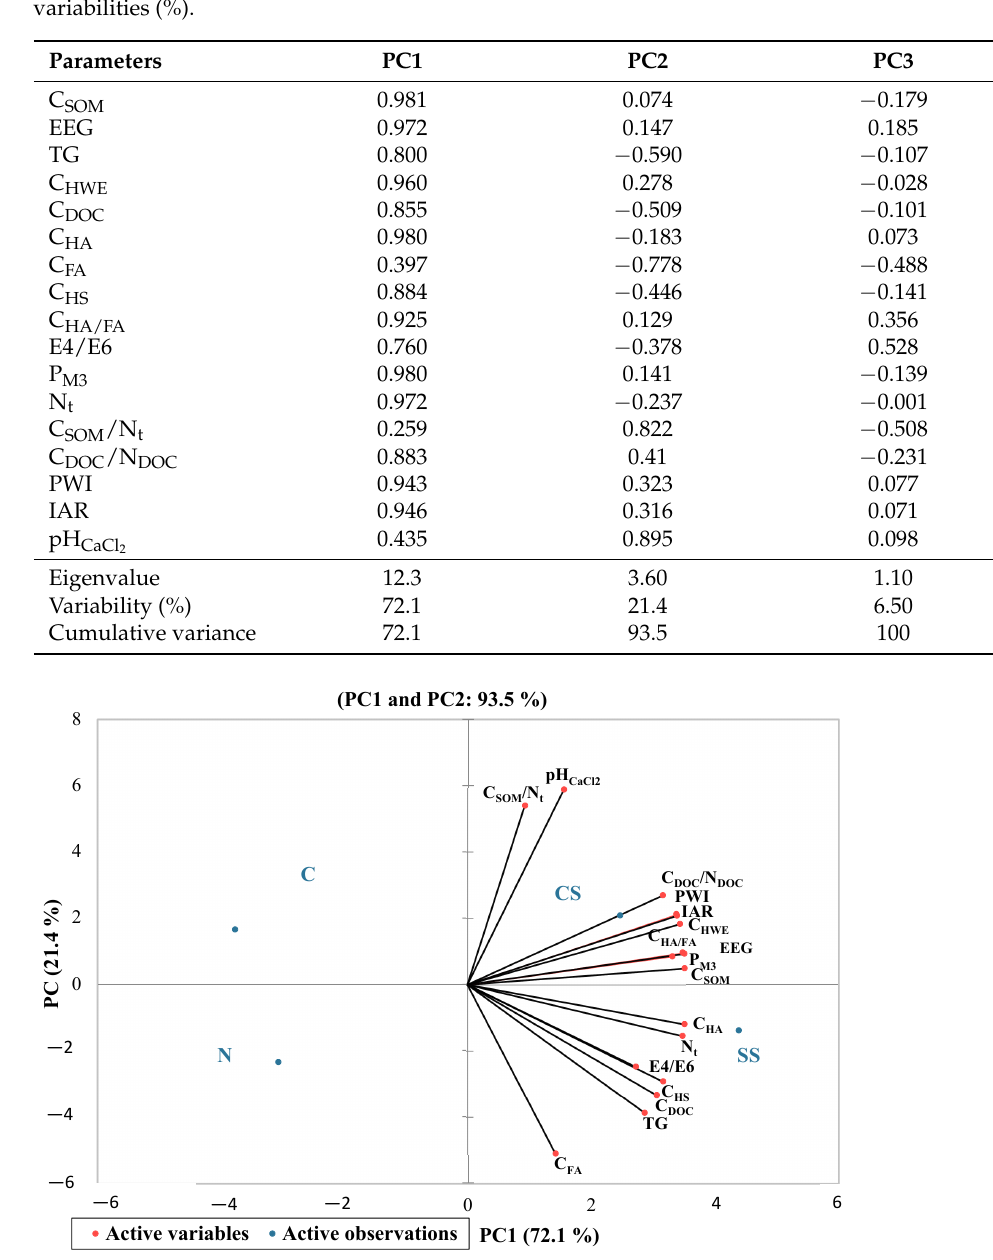
Figure 1. The biplot position of variables is determined by the first two principal components (PC1 vs. PC2); the red and blue dots represent active variables and observations, respectively.